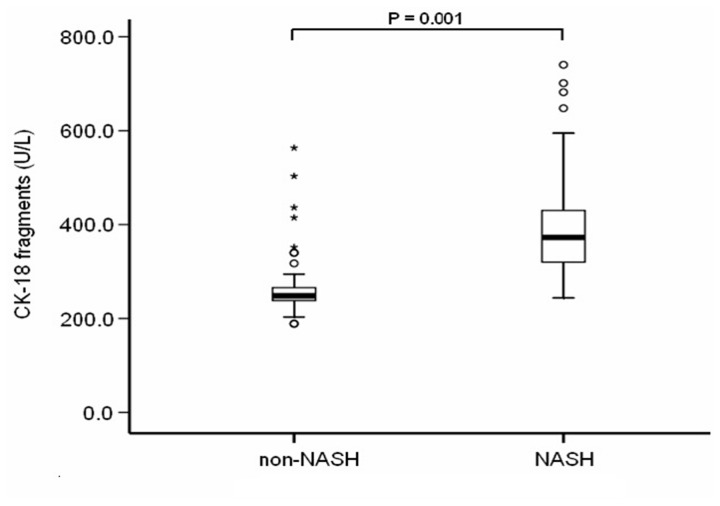
CK-18 fragments are significantly higher in the serum with NASH compared to patients with non-NASH.The vertical axis represents serum CK-18 levels in U/L, whereas the horizontal axis refers to patient groups. The box and bars represent the interquartile range (the 25th and 75th percentiles) from the median (the horizontal line) and the 95% confidence interval, respectively. CK-18 fragments levels significantly increased in patients with NASH compared to non-NASH patients (median (Q25, Q75): 372.9 U/L (319.6, 431.4), 248.1 U/L (237.5, 266.6), respectively; P < 0.001).